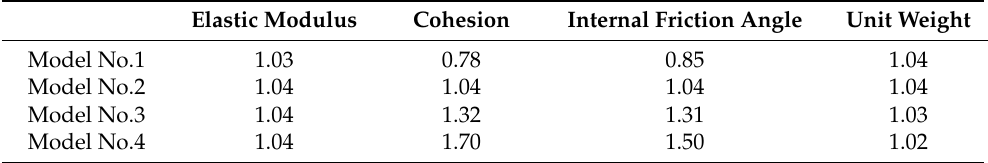
Table 13. Slope stability coefficient with different material parameters.